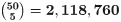
Power of indirect CTD p-value estimation compared to permutation-based p-value estimation.For three separate network structures containing 50 nodes at variable levels of connectedness (network 1: 10% connected; network 2: 30% connected; network 3: 60% connected), p-values for node sets of size 5 were estimated by three estimation methods: “ground truth” enumeration, permutation-testing and upper bound estimation by CTD. Ground truth was calculated via brute force enumeration for all (505)=2,118,760 node set outcomes of size 5. (A) CTD p-value bounds were more conservative than permutation-based p-value estimates. However, for highly connected node sets which were given more significant p-value bounds by CTD, the difference between CTD’s upper p-value bounds and the ground truth p-value is smaller. (B) Power associated with CTD upper-bounds on p-values was estimated. For all experiments where the brute force p-value was less than or equal to a given significance level (e.g., 0.05), power is calculated based on the percentage of those experiments where the CTD upper bounds p-value estimate was also less than or equal to the given significance threshold (i.e., the true positive rate). Similar to the view of the data in (A), we see that CTD’s p-value bounds show higher power for highly connected node sets compared to sparsely connected node sets.